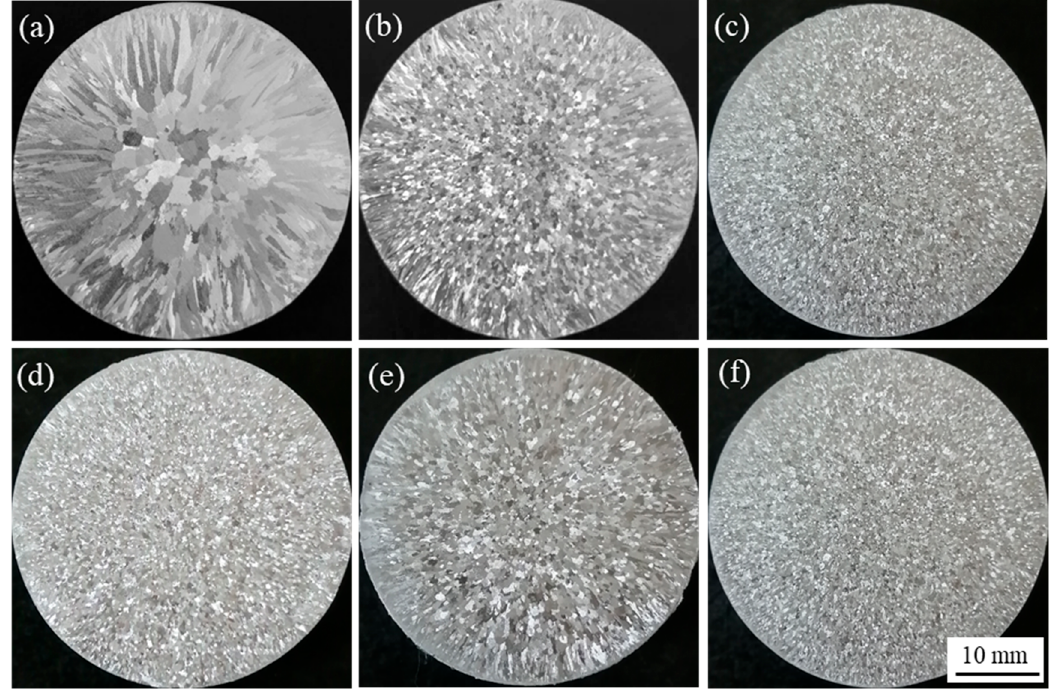
Figure 12. The macrographs of A 99.7 with 0.3% different master alloys: ( a ) unrefined; ( b ) #1; ( c ) #2; ( d ) #3; ( e ) #4; ( f ) #5.